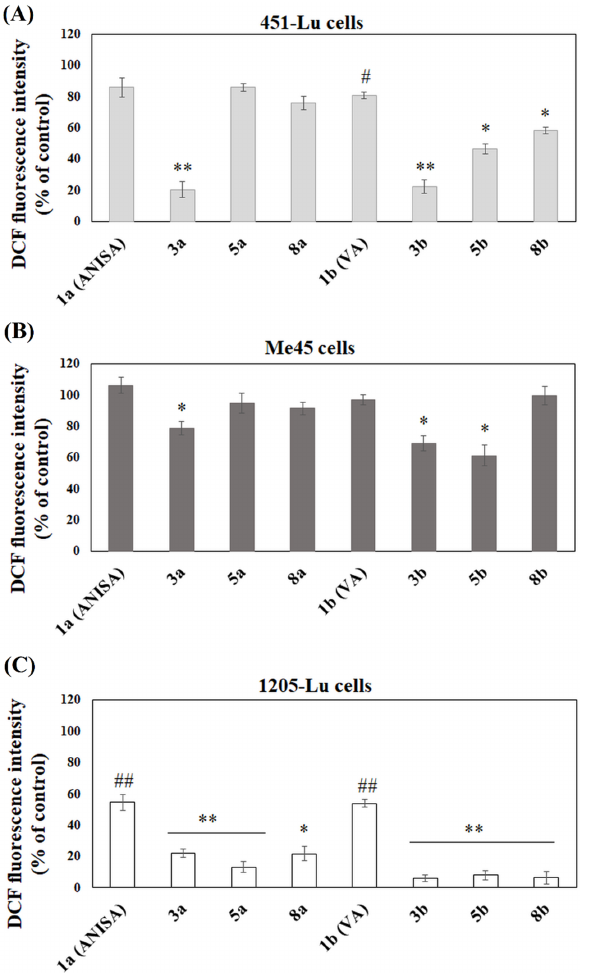
Figure 2. The influence of ANISA, VA and their conjugates on the reactive oxygen species formation in 451-Lu ( A ), Me45 ( B ) and 1205-Lu ( C ) melanoma cells. The results were presented as percentages of the control (no compound). In the case of the free acids ANISA and VA, statistical significance was compared to the samples containing no compounds (# p < 0.05; ## p < 0.001), whereas, in the case of PC-conjugates, to the samples containing ANISA or VA (* p < 0.05; ** p < 0.001). PC-conjugates, to the samples containing ANISA or VA (* p < 0.05; ** p <